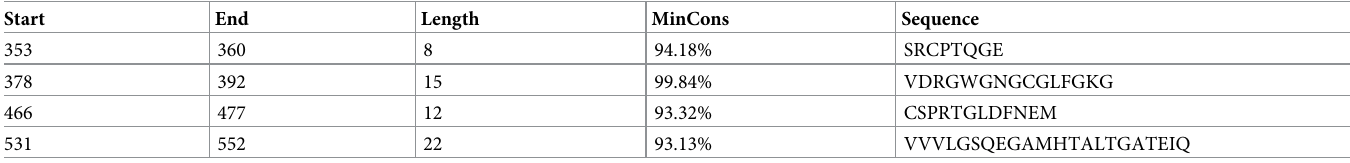
Table 1. Conserved region of dengue envelope